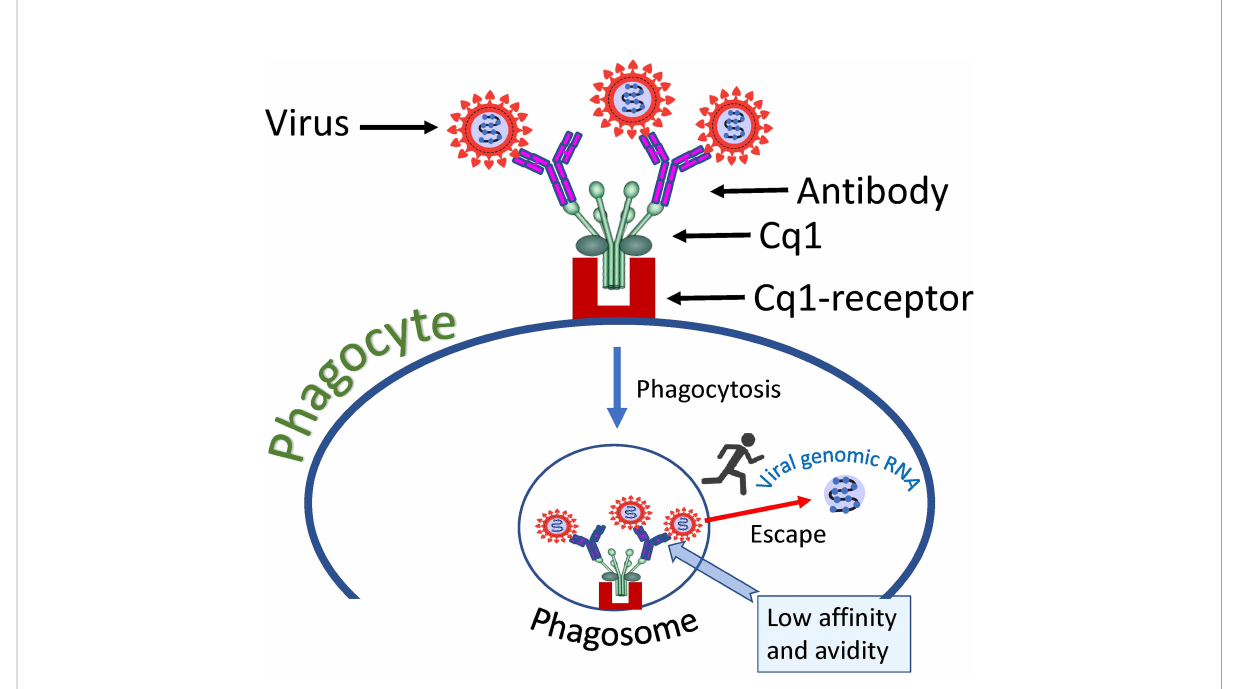
FIGURE 4 Hypothetical mechanism of SARS-CoV-2 entry into a cell via complement receptors. The low af fi nity of the antibody, which causes a loose connection to the virus, allows the virus to escape the complex and fuse its envelope to the phagosome membrane, thus introducing its genome into the cell